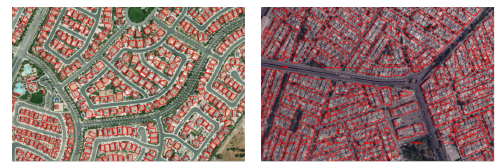
Figure 1. A comparison of building footprint extraction in dif- ferent areas. On the left side, successful building extraction has been performed using deep learning models with high-resolution imagery in the USA (ESRI, 2020). On the right, similar methods have been applied but with much lower resolution and densely packed areas of